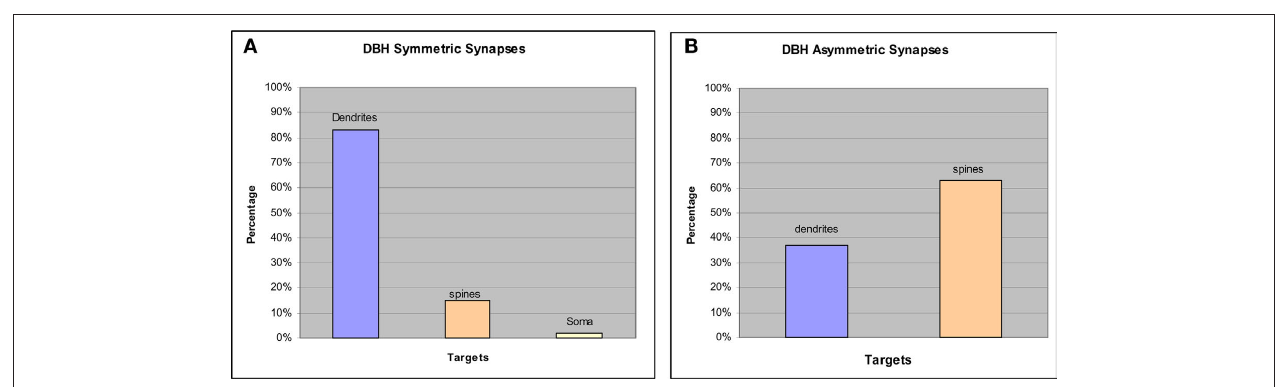
Figure 5 | graphs show synaptic targets and specializations made by D β H terminals that form synapses. (A) The vast majority of DBH symmetric synapses occurred on dendrites but a small proportion were made onto spines and somata. (B) Most DBH asymmetric synapses occurred on spines though some were formed on